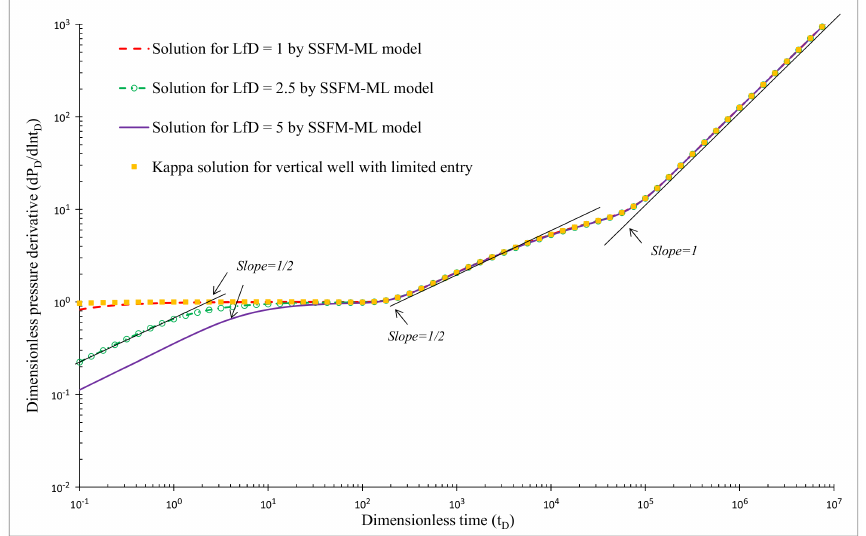
Figure 6. Dimensionless pressure derivative response under various fracture lengths from 2-layer SSFM-ML model illustrated by the three curves with h f 1 D = h f 2 D = 250, N stage = 1; h e 1 D = h e 2 D = 500, pressure derivative of a vertical well with limited entry generated from commercial software Kappa by its homogeneous reservoir model and partially penetrating vertical well model with r wD = 1. They both have the same reservoir geometry and properties.